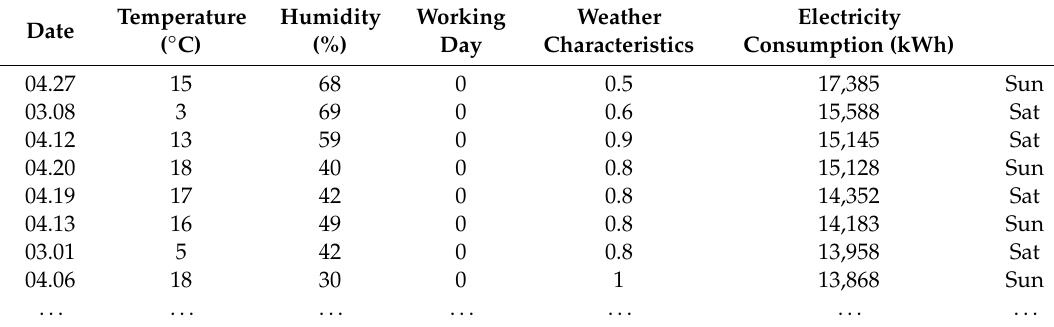
Table 4. Part of training data in Appendix